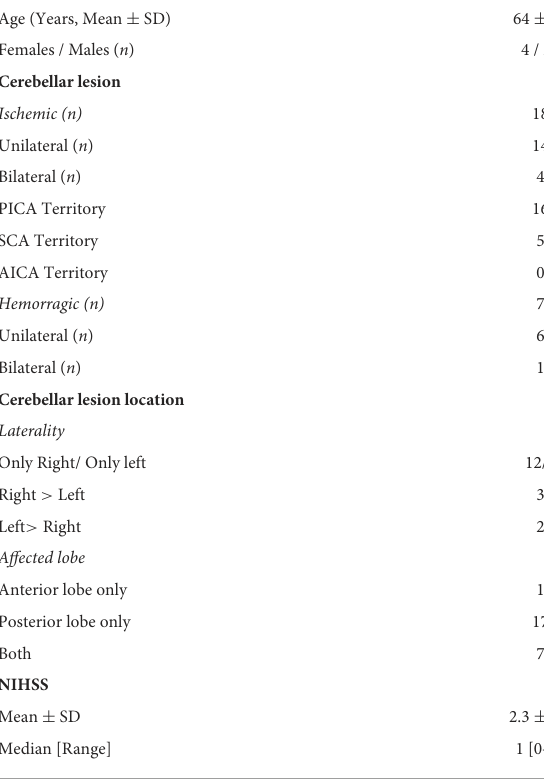
TABLE 1 Patients’ characteristics.